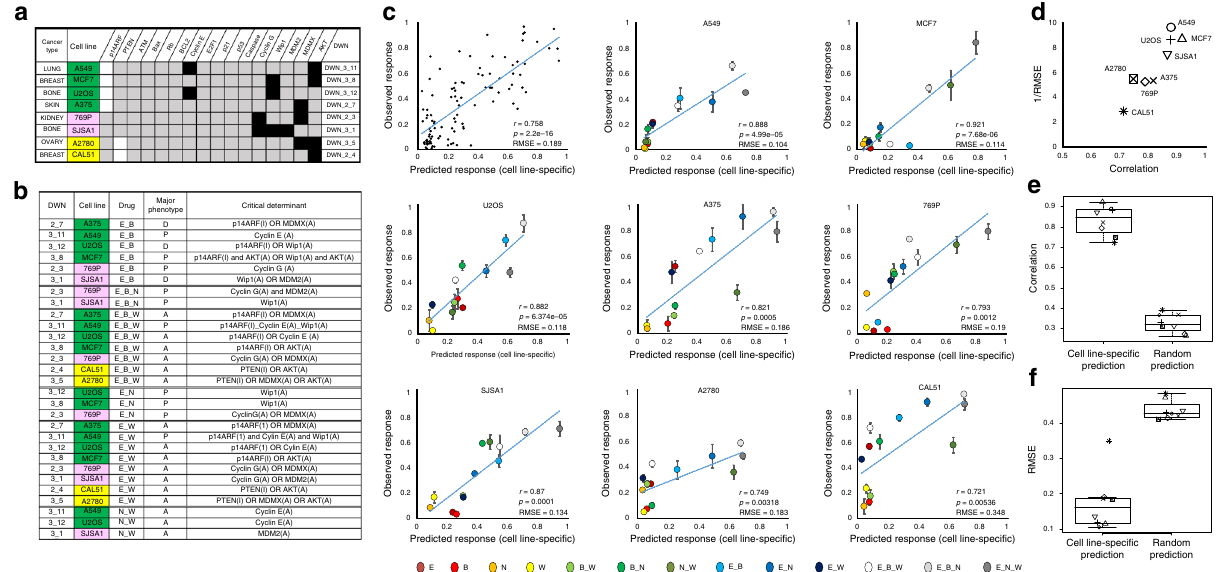
Fig. 5 Experimental validation of the drug response pro fi les of eight cancer cell lines in the panel. a Differentially wired networks corresponding to the eight distinct cancer cell lines (A549 (lung, DWN_3_11), MCF7 (breast, DWN_3_8), U2OS (bone, DWN_3_12), A375 (skin, dwn_2_7), 769p (kidney, DWN_2_3), SJSA1 (bone, DWN_3_1), CAL51 (breast, DWN_2_4), A2780 (ovary, DWN_3_5). b Predicted major drug response phenotype and the associated critical determinant for the eight cell line-speci fi c networks in response to various perturbations. c Scatter plots of the experimentally observed vs. predicted cell death ratio for all cell lines combined and each individual cell line. The error bars indicate the standard deviation of time-lapse imaging experiments under various drug treatment conditions. d Evaluation of drug response prediction results acquired by our network dynamics analysis using Pearson correlation and RMSE. e , f Comparison of the predictive power of our network dynamics analysis and random prediction using Pearson correlation and